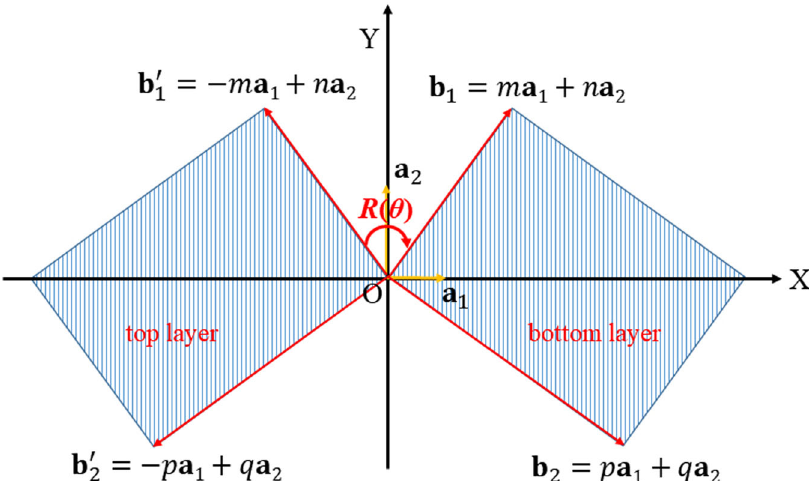
Fig. 1 Forming process of twisted bilayer. Schematics of the forming process of a twisted bilayer for orthorhombic lattice. a 1 and a 2 are basis vectors for primitive cell, while b 1 and b 2 are the supercell basis vectors of the bottom layer, b 0 top layer before twisting. m , n , p and q are integers, and it is required that b 1 is perpendicular to b 2 .